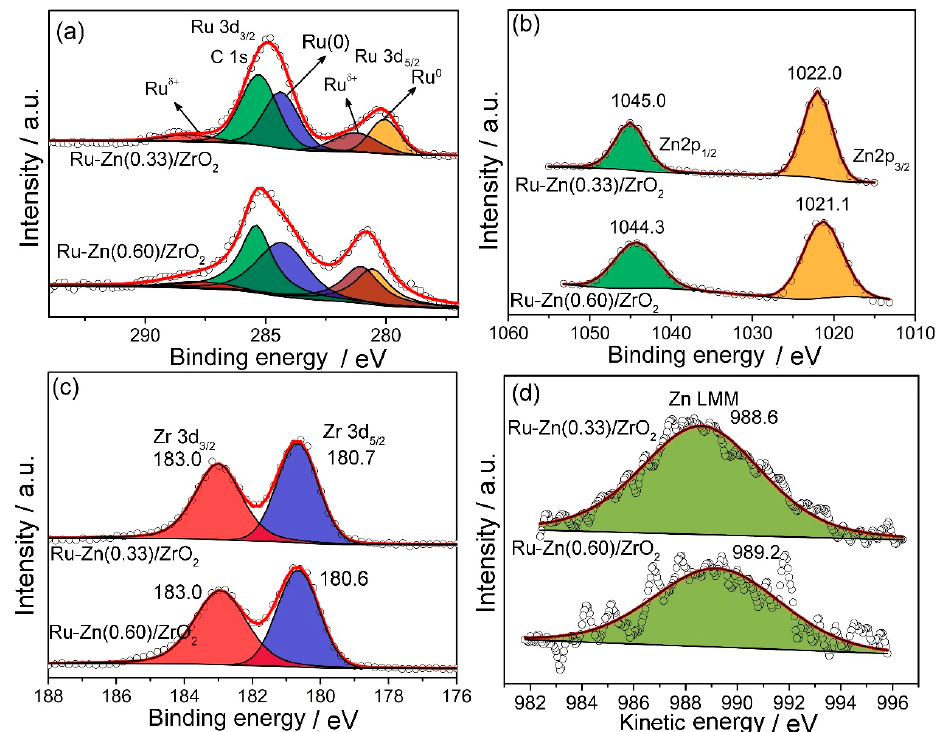
Figure 3. X-ray photoelectron spectroscopy (XPS) profiles of Ru-Zn (0.33)/m-ZrO 2 catalyst and Ru-Zn (0.60)/m-ZrO 2 catalyst after catalytic experiments. ( a ) Ru3d 3/2 and Ru3d 5/2 ; ( b ) Zn2p 1/2 and Zn2p 3/2 ; ( c ) Zr3d 3/2 and Zr3d 5/2 ; ( d ) Zn LMM.